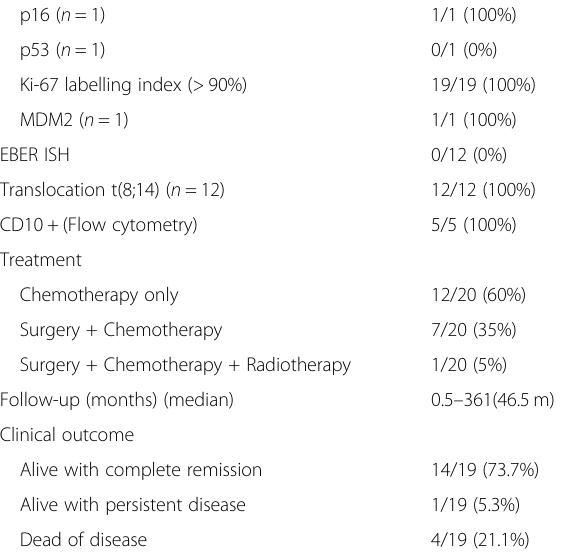
Table 1 Clinicopathological characteristics of 21 thyroid Burkitt ’ s lymphomas by meta-analysis of the literature